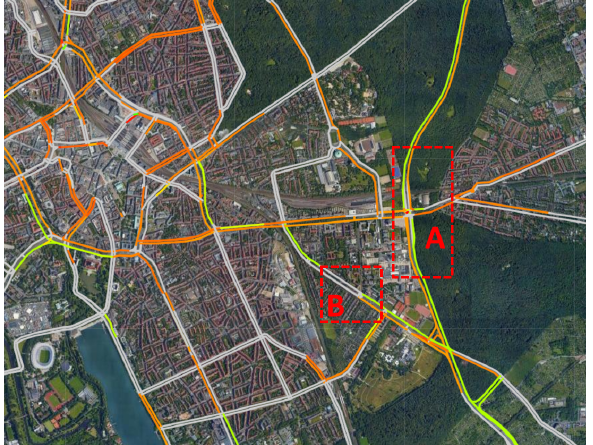
Figure 3. The times of the daily traffic load peak per segment indicate when the traffic load is at its maximum, the velocity is minimal, respectively. The spectral color scheme encodes the time of the day. Green means early (usually in the morning), red late (afternoon/evening). Gray segments do not have a significant peak at all. The marked places A and B show two situations of interesting behaviour. Map source: GoogleEarth OSM-based Features. From OSM traffic signals are extracted. They are assigned to nearby segments. To prevent double assign- ments from different directions, signals were clustered spatially. The feature #traffic lights value contains the number of intersect- ing clusters.